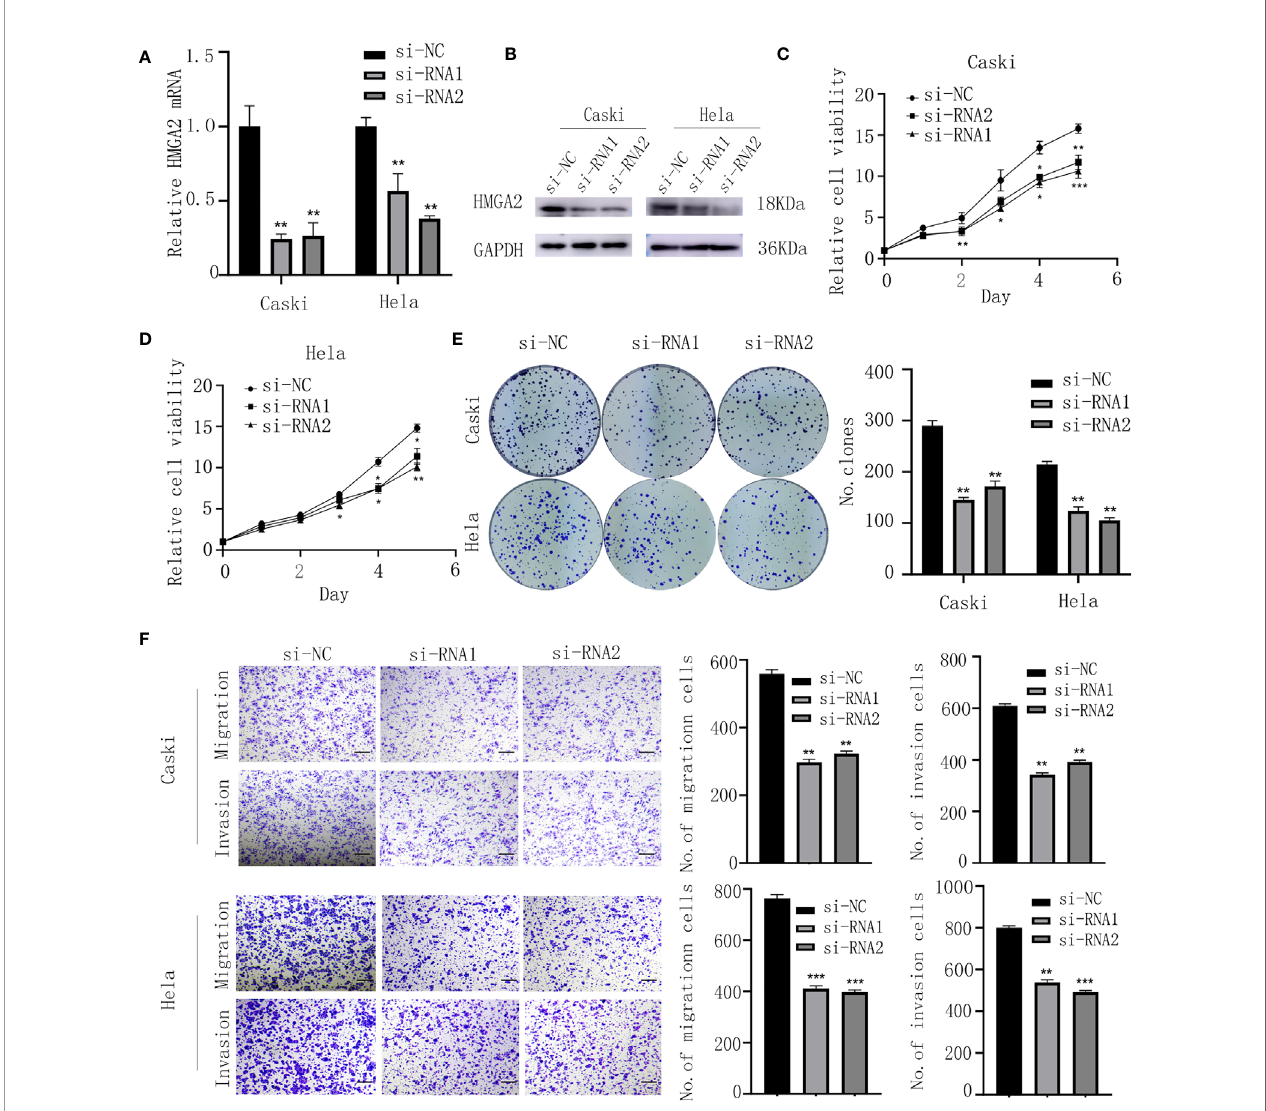
FIGURE 7 | Knockdown of HMGA2 inhibits the proliferation, migration and invasion of CC cells. (A, B) Successfully knockdown of HMGA2 using two independent siRNAs in caski and hela cells was veri fi ed by qRT-PCR and western blotting. (C, D) Proliferation of caski and hela cells was measured by CCK8 assay after HMGA2 knockdown. (E) Colony formation ef fi ciency of caski and hela cells was assessed by clonogenic assay after HMGA2 knockdown. (F) Migration and invasion of caski and hela cells were evaluated by transwell assay after transfection with si-HMGA2 or si-NC. Scale bar; 50 m m. (Data are mean ± SEM, *p < 0.05, **p < 0.01, ***p < 0.001, n =